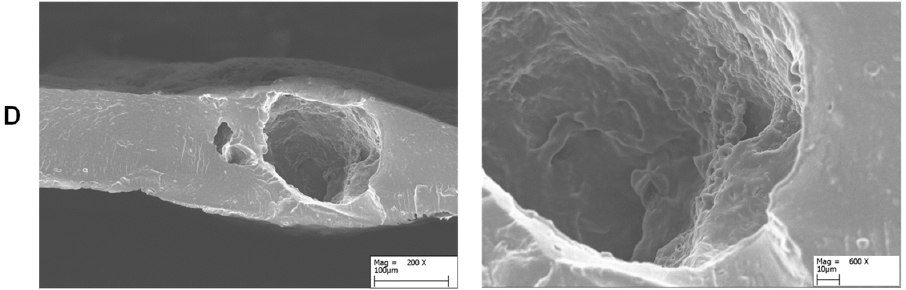
Figure 5. SEM images in two different magnifications of the cross-section morphology of PE- g -PSSNa membranes with various blend compositions: ( A ) M1; ( B ) M3; ( C ) M4; ( D ) M5.